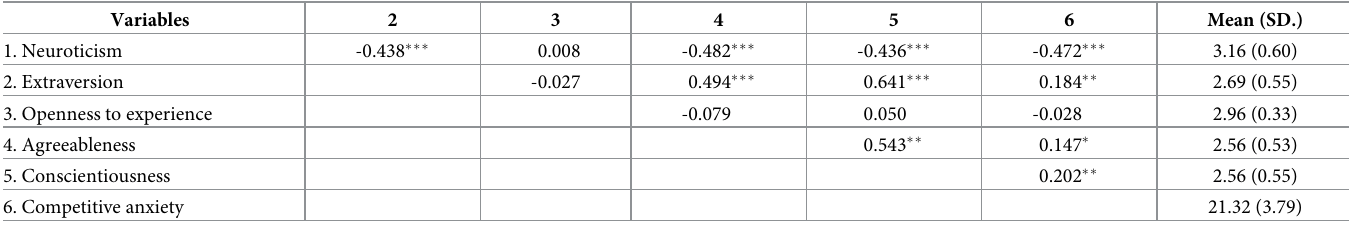
Table 2. Relationships between personality and competitive anxiety in all athletes (n = 237). Variables